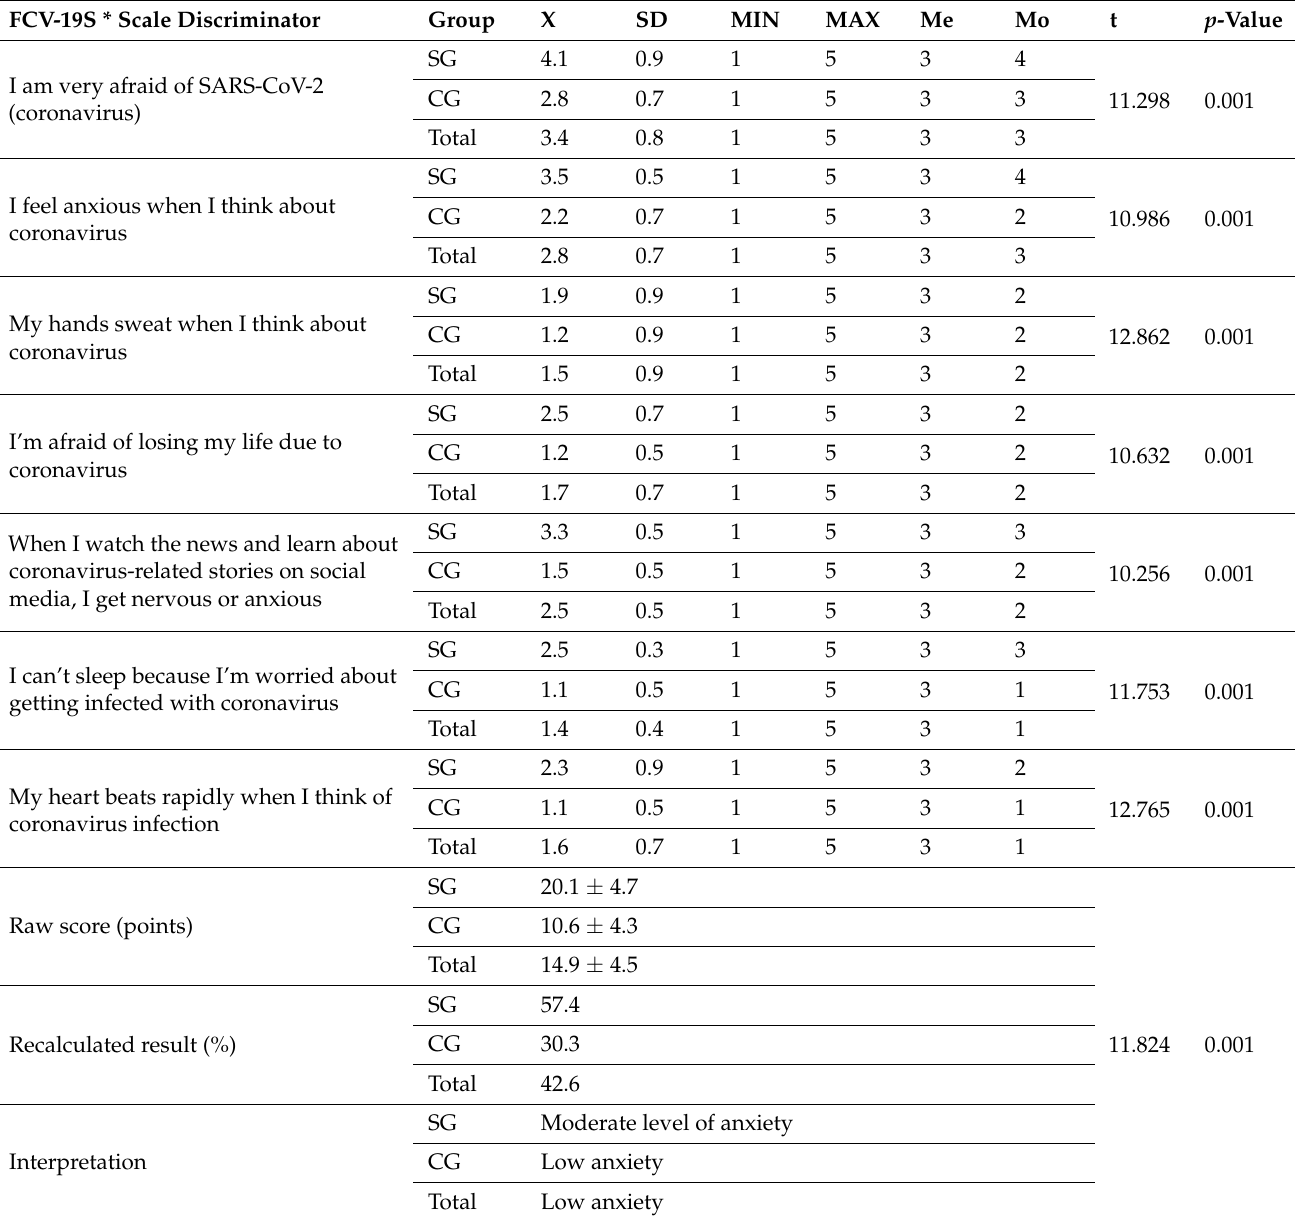
Table 3. FCV-19S scale scores in oncology patients (SG) and control group (CG) (N =